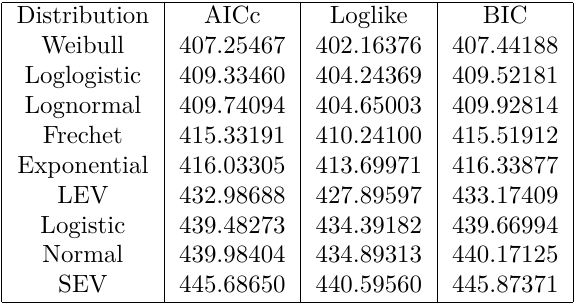
Table 3. Comparisons of the distribution of the measured data for Material#3.